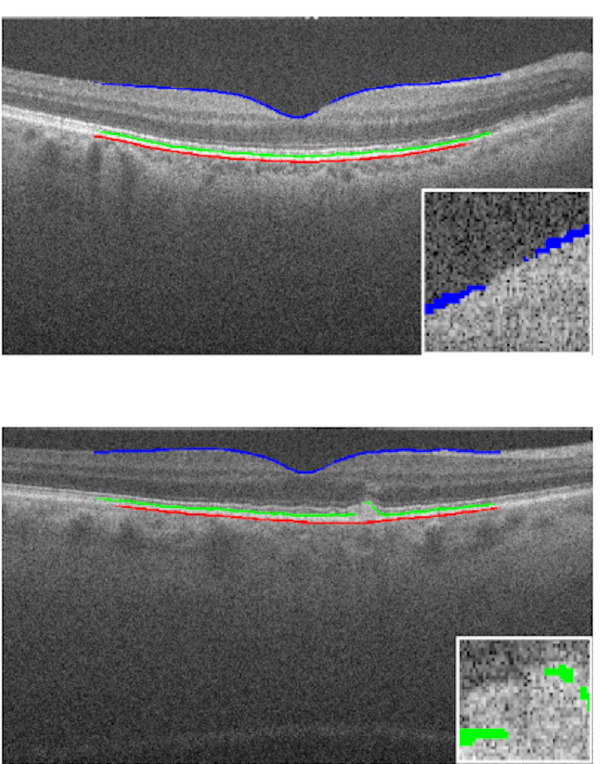
Fig 10. Examples of edge detection failure. (a) Exam B-scan 46 “AMD_1053”. (b) Exam B-scan 32 “AMD_1081”.